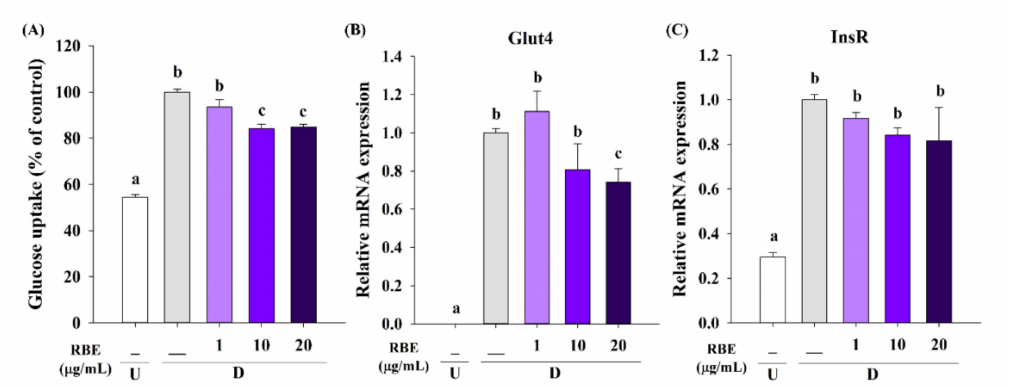
Figure 7. E ff ect of Riceberry rice extract (RBE) on glucose uptake in mature adipocytes. ( A ) RBE at 10 and 20 µ g / mL significantly reduced glucose uptake into mature adipocytes after 8 days of treatment. ( B ) Downregulation of Glut4 mRNA expression in response to RBE at 20 µ g / mL in di ff erentiated cells. ( C ) Treatment of cells with RBE did not impact insulin receptor (InsR) mRNA expression. The results are expressed as mean ± SEM from the three independent experiments. Groups with a di ff erent letter represent statistical significance ( p < 0.05). Data were normalized with β -actin as an internal control. U: undi ff erentiated cells; D: di ff erentiated cells.